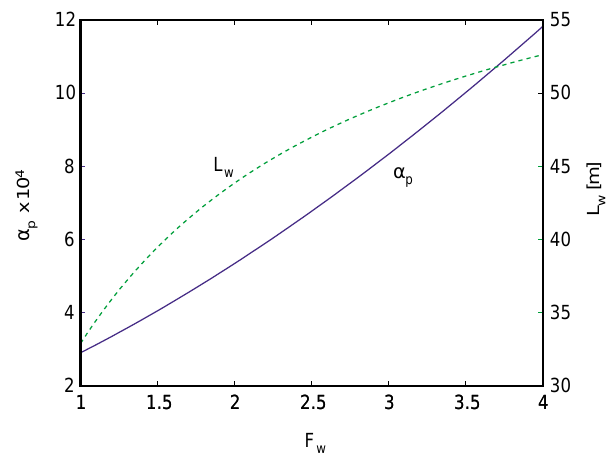
FIG. 11. (Color) Momentum compaction a p and wiggler length L w plotted versus wiggler damping F w .